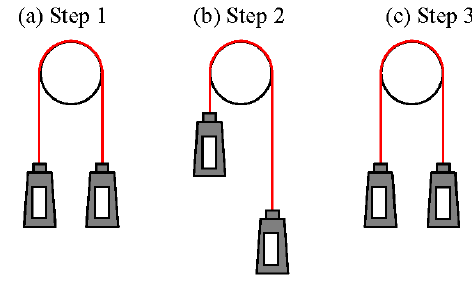
Figure 6. Experimental setup.